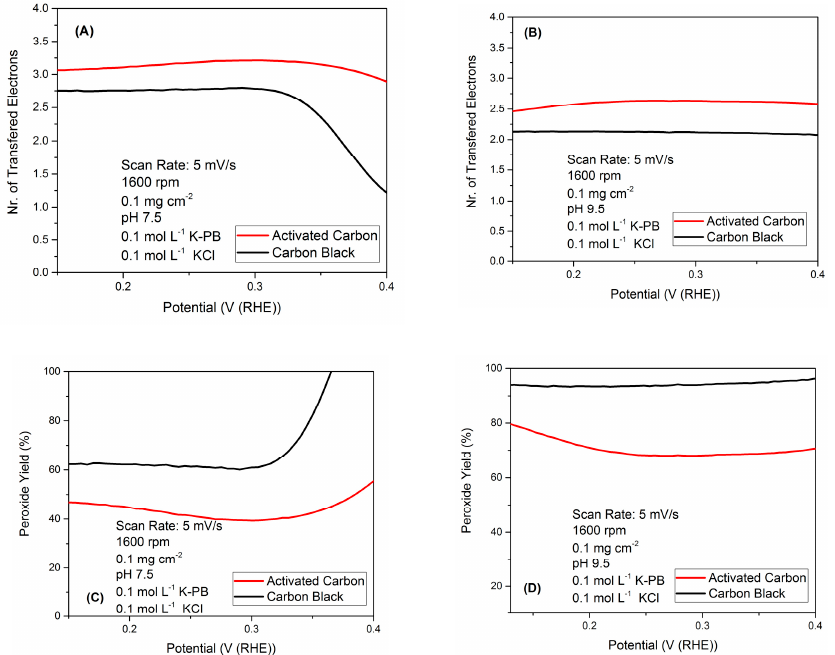
Figure 2. Estimated number of transferred electrons for the AC (activated carbon) and CB (carbon black) from the RRDE (rotating ring disk electrode) measurements at pH 7.5 ( A ) and pH 9.5 ( B ). The estimated peroxide yield for the AC and CB from the RRDE measurements at pH 7.5 ( C ) and pH 9.5 ( D ).